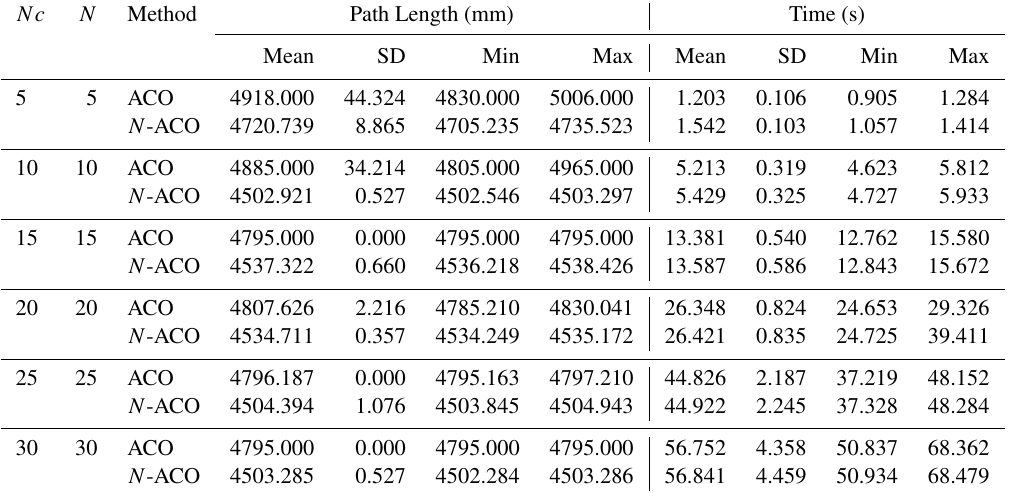
Table 4. comparison of performance indexes of each algorithm.